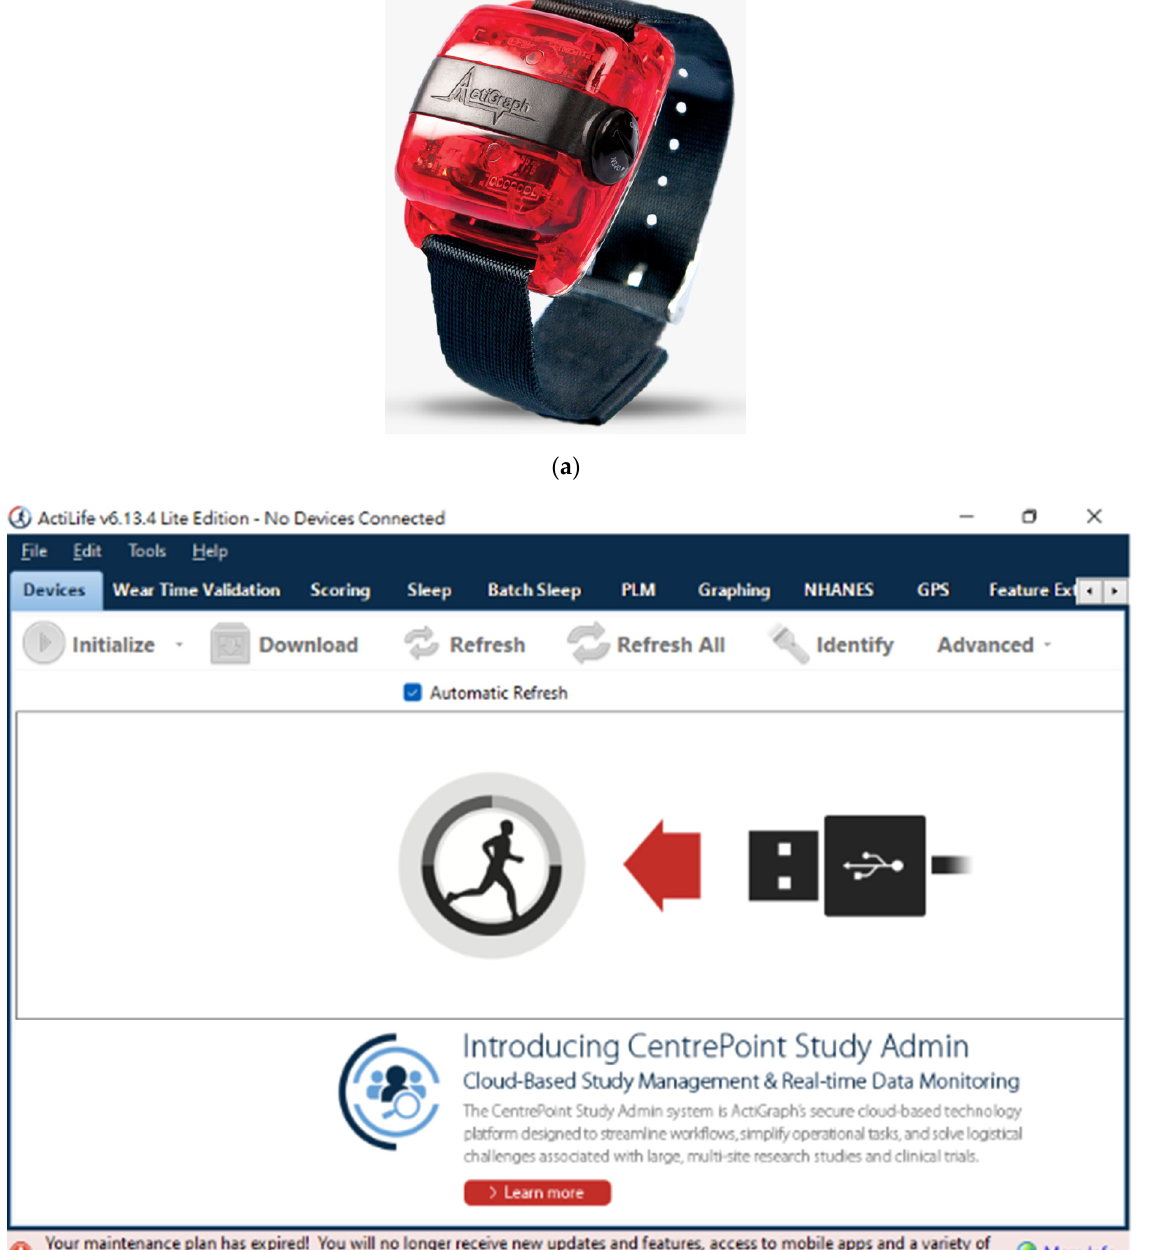
Figure 6. Biological physiological characteristic information collection equipment wGT3X-BT ( a ) The WGT3x-BT wrist meter host of ActiGraph; ( b ) ActiLife analysis software provided by ActiGraph. The monitor used for the typing test in this study was ASUS VE247H display (23.6 inch, FHD, Panel Backlight: LED, Brightness: 300 cd/m 2 ). The indoor ambient light spectrum of its typing test is shown in Figure 8. The light source emitted by the display reaches a peak value of corneal illumination measurement of 11 lux, and the frequency spectrum was measured in a dark room, as shown in Figure 9, according to the standard of ITU-R BT.500-13